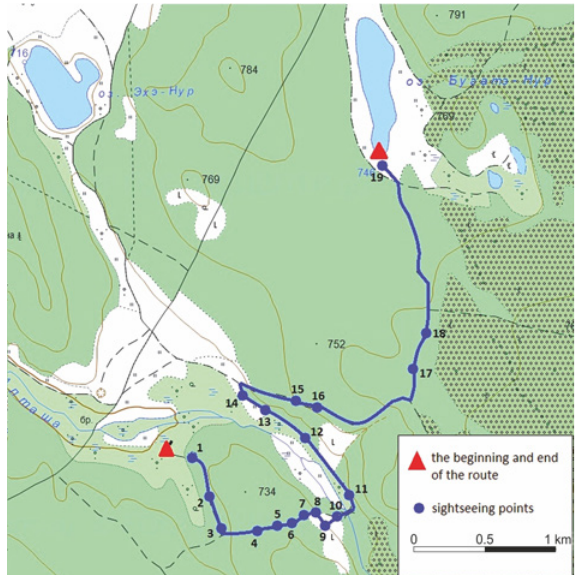
Fig. 2. Scheme of ecological tour route “To lake